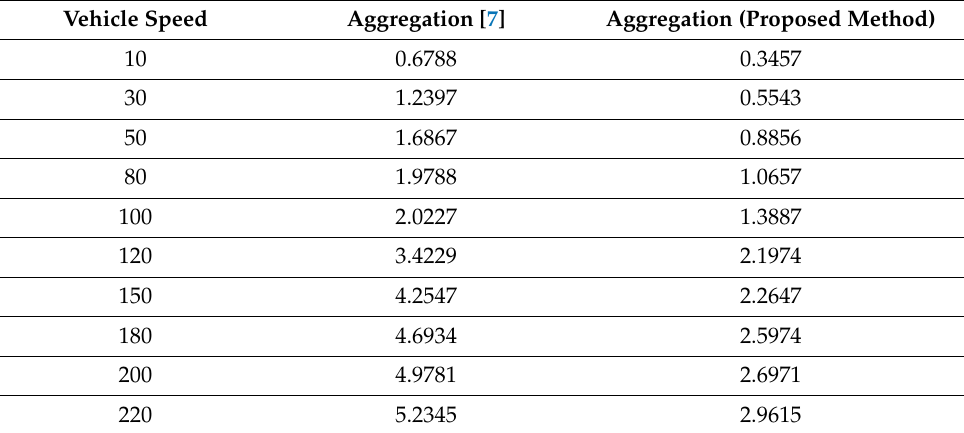
Table 5. Aggregation time.